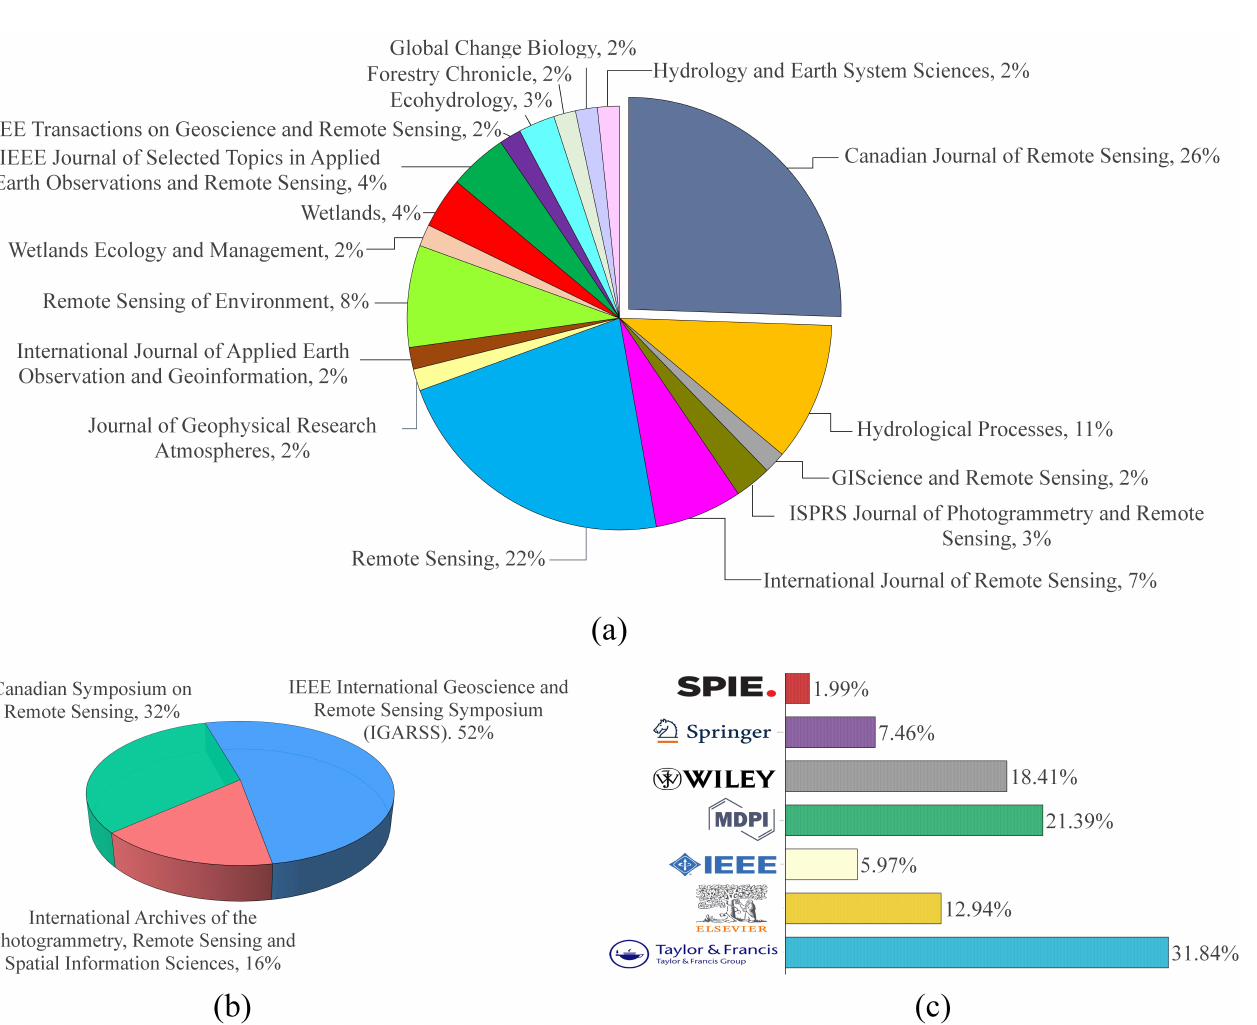
Figure 6. Percentage of published RS-based wetland studies in Canada per ( a ) journal, ( b ) international conference, and ( c )